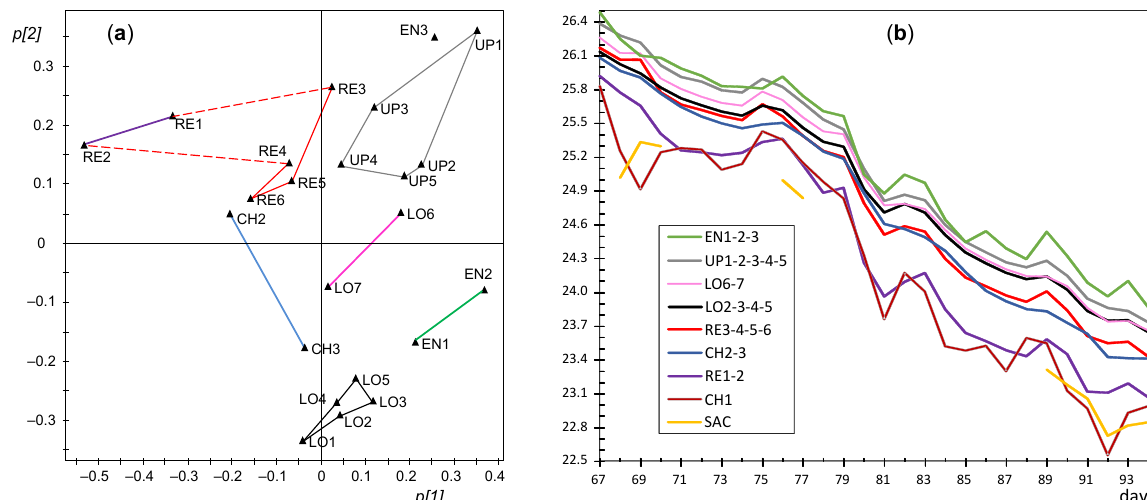
Figure 21. PCA of daily medians for the period of days 67–94 after discarding nodes CH1, OUT, and SAC: ( a ) loading plot for PC1 and PC2 ( p[2] vs. p[1] loadings), ( b ) time series of daily median temperatures from day 67–94. Trajectories were averaged according to clusters indicated in ( a ).